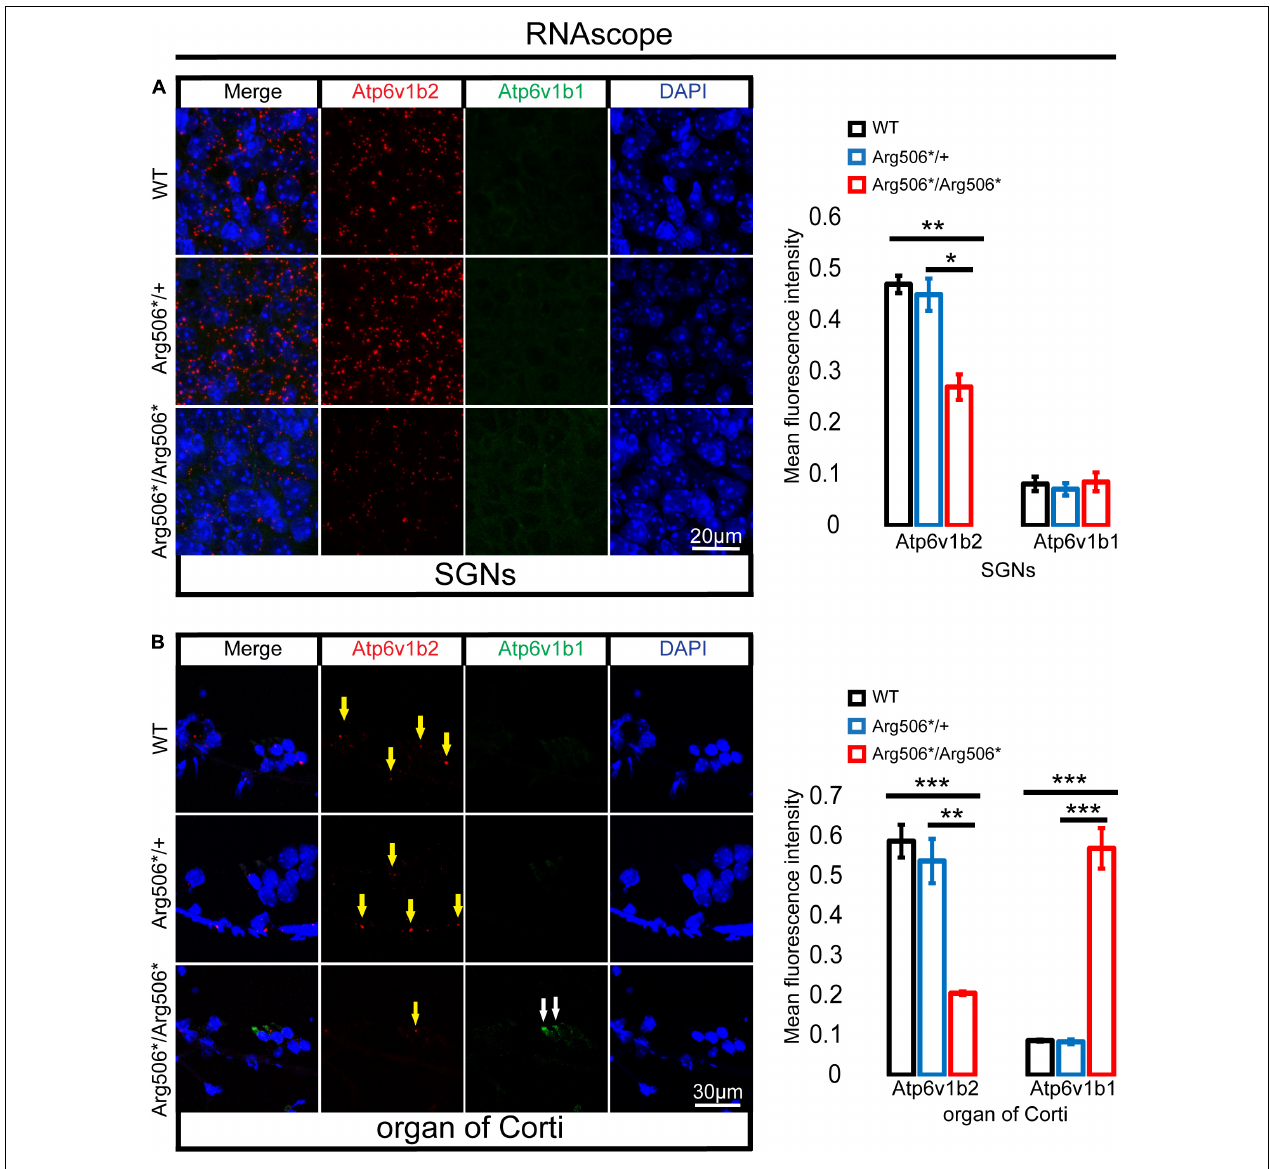
FIGURE 5 | Increased transcription of Atp6v1b1 occurs in the hair cells of Atp6v1b2 Arg 506 ∗ / Arg 506 ∗ mice. (A) Representative images and quantification of RNAscope results in the spiral ganglion neurons (SGNs). The mean fluorescence intensity of Atp6v1b2 RNA in Atp6v1b2 Arg 506 ∗ / Arg 506 ∗ mice was significantly lower than that in WT and Atp6v1b2 Arg 506 ∗ / + mice. No Atp6v1b1 RNA was found in the SGNs. (B) Representative images and quantification of RNAscope results in the organ of Corti. Atp6v1b2 RNA decreased in Atp6v1b2 Arg 506 ∗ / Arg 506 ∗ mice compared with that in WT and Atp6v1b2 Arg 506 ∗ / + mice (yellow arrow). There was no significant difference in the mean fluorescence intensity of Atp6v1b2 RNA between WT and Atp6v1b2 Arg 506 ∗ / + mice. Atp6v1b1 RNA was found in the hair cells of Atp6v1b2 Arg 506 ∗ / Arg 506 ∗ mice (white arrow) but not in the hair cells of WT and Atp6v1b2 Arg 506 ∗ / + mice. n = 3 for each group. * denotes P < 0.05, ** denotes P < 0.01 and *** denotes P < 0.001. Data are described as mean ± SEM (standard error of